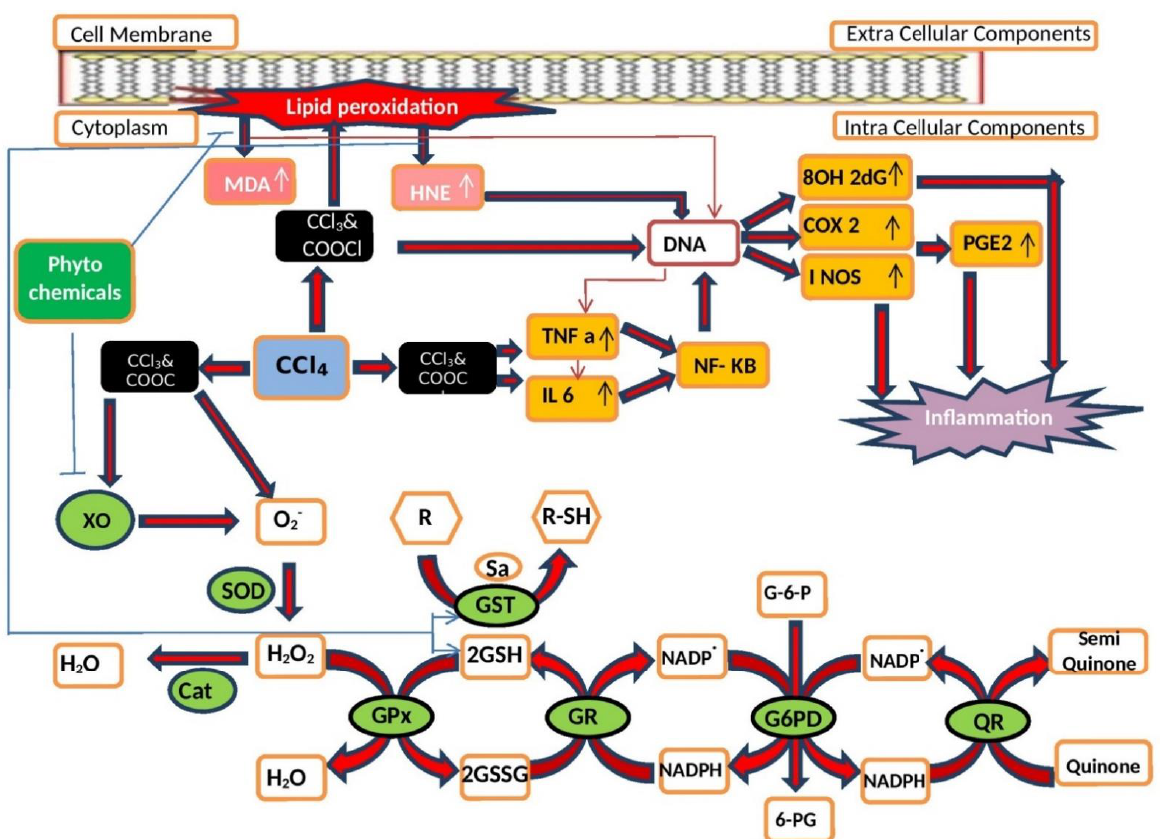
Figure 1. Effects of carbon tetrachloride (CCl 4 )-induced ROS on the defense mechanisms of antioxi- dant enzymes and phytochemical compounds with antioxidant properties. The antioxidant enzymes xanthine oxidase (XO), superoxide dismutase (SOD), catalase (CAT), glutathione peroxidase (GP), glutathione reductase (GR), glucose 6 phosphate dehydrogenase (G6PD), glutathione S-trans- ferase (GST), and quinone reductase (QR) along with phytochemical compounds can reduce the harmful effects of ROS by decreasing the extent of malondialdehyde (MDA) production, elevating the levels of reduced glutathione (GSH), and reducing the overproduction of 4-hydroxynonenal (HNE) protein adducts and 8-hydroxy- 2′ -deoxyguanosine (8OHdG) as well as by overexpressing tumor necrosis factor-alpha (TNF- α), interleukin 6 (IL6), and prostaglandin E2 (PGE2).